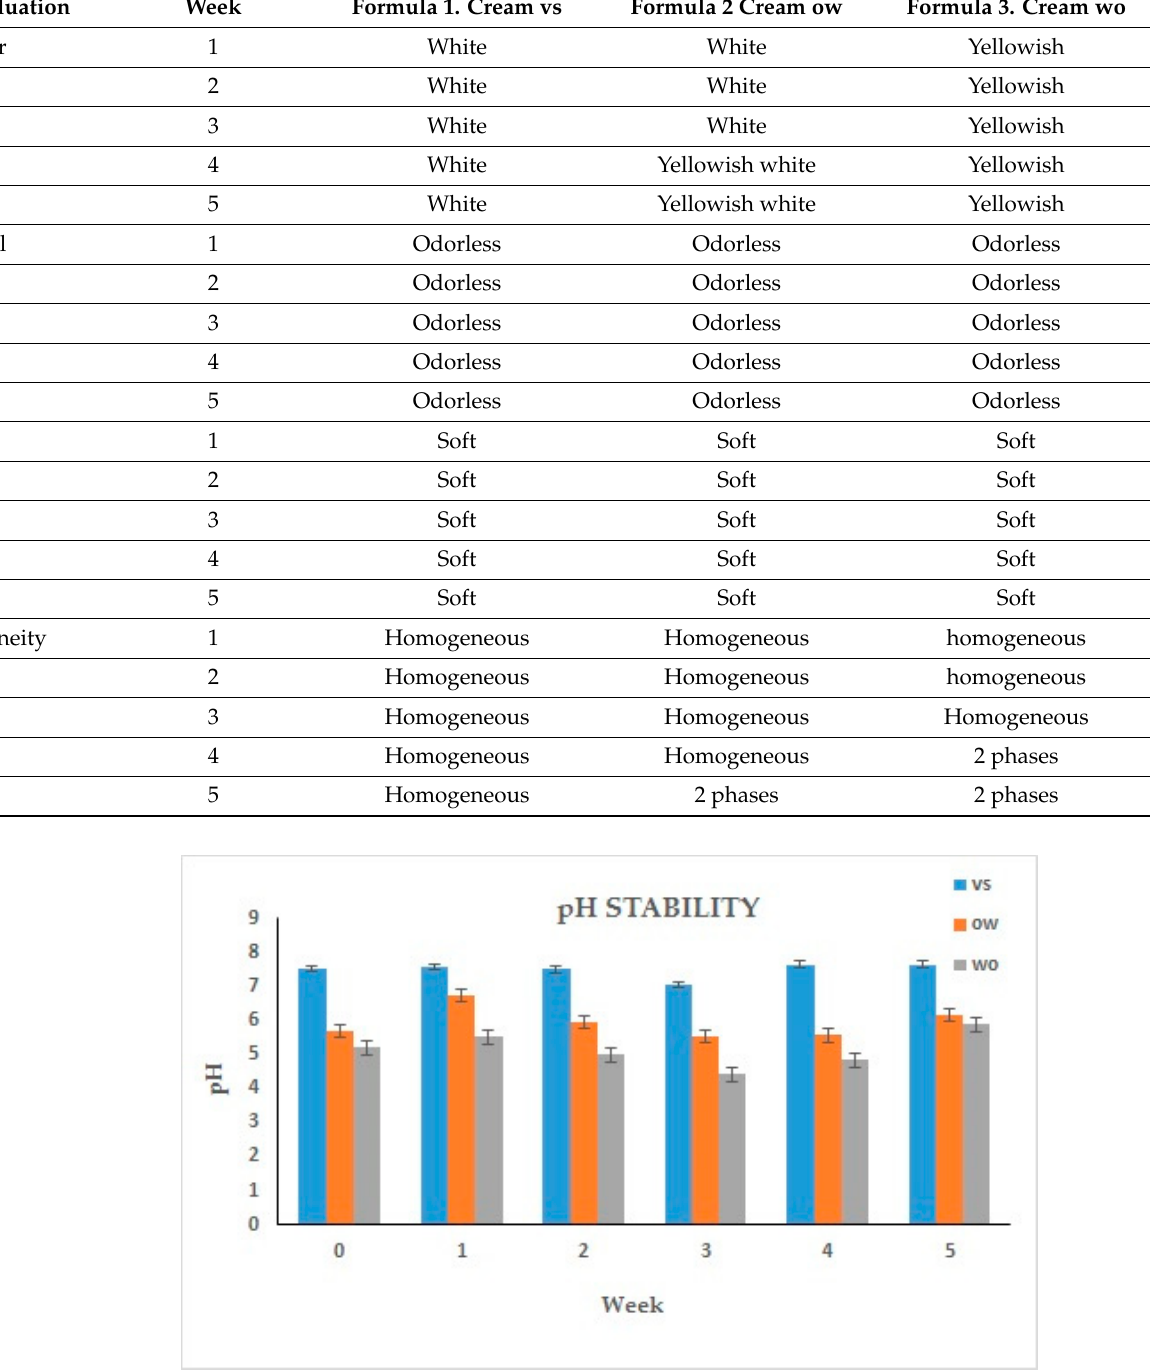
Table 3. Organoleptic stability of cream